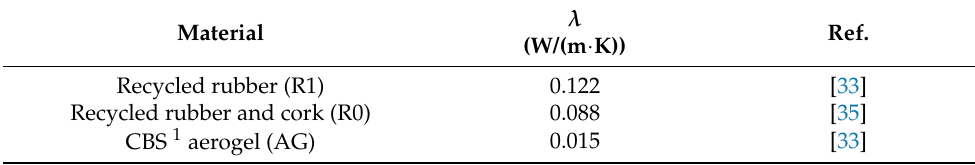
Table 2. Thermal break strips: material and thermal conductivity ( λ ).